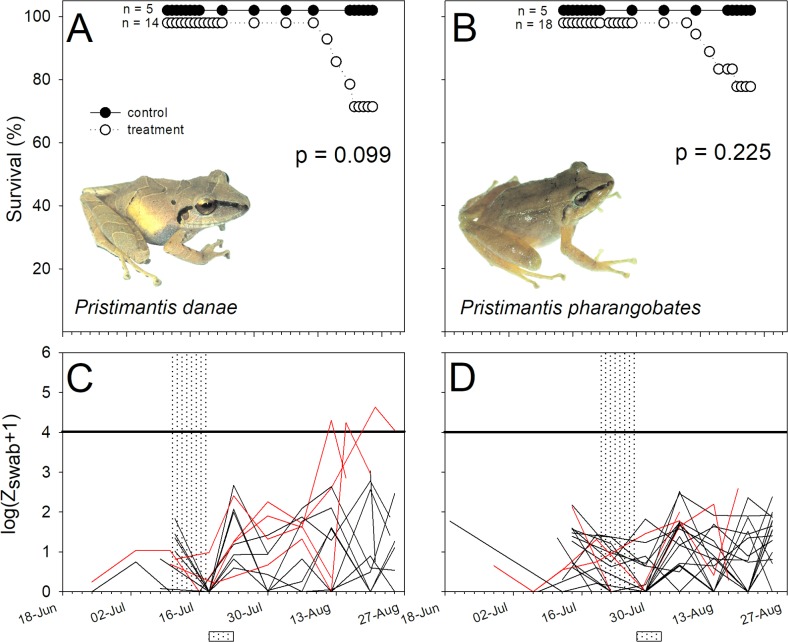
Differences in survival and Bd infection intensity in two non-susceptible species of terrestrial-breeding frogs, Pristimantis danae and Pristimantis pharangobates (Craugastoridae).(A, B) Percentage survival, and (C, D) variation in log-transformed zoospore equivalents (Bd infection intensity) of Bd-exposed individuals of Pristimantis danae (left panels) and P. pharangobates (right panel). See Fig 2 for caption details.